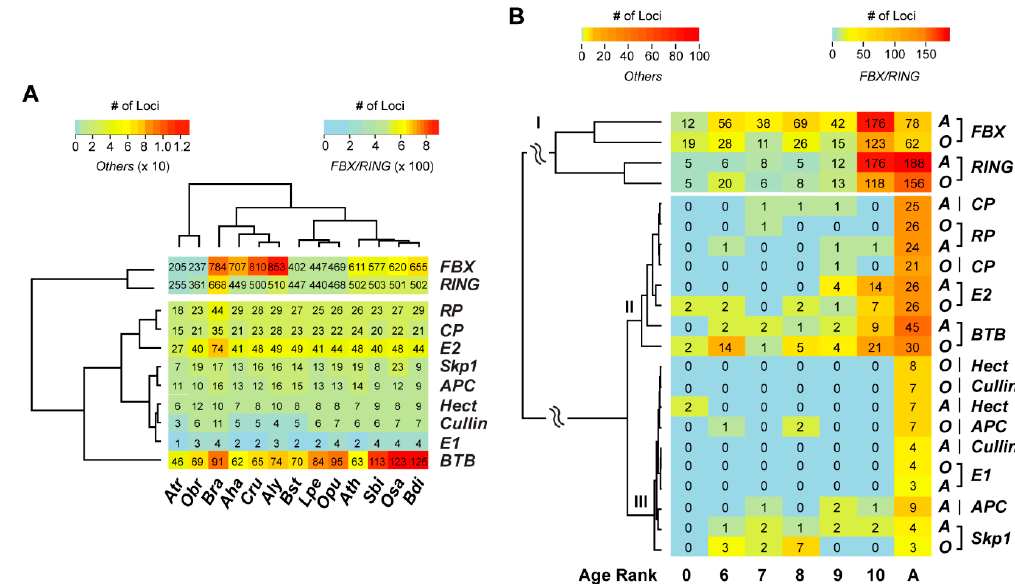
Figure 3. Size comparison of orthologous members across plant genomes revealed large, medium, and small groups of UPS families. ( A ) Clustering of OrthoMCL members reflected differential expansion of 11 UPS families across 13 plant genomes. ( B ) Age-ranked expansion of orthologous genes from 11 UPS families in Aly ( A ) and Osa ( O ) genomes revealed three major clusters. The number of orthologus genes is counted based on the orthologous groups present in each age rank. Orthologous group age ranking is described in Section 4.